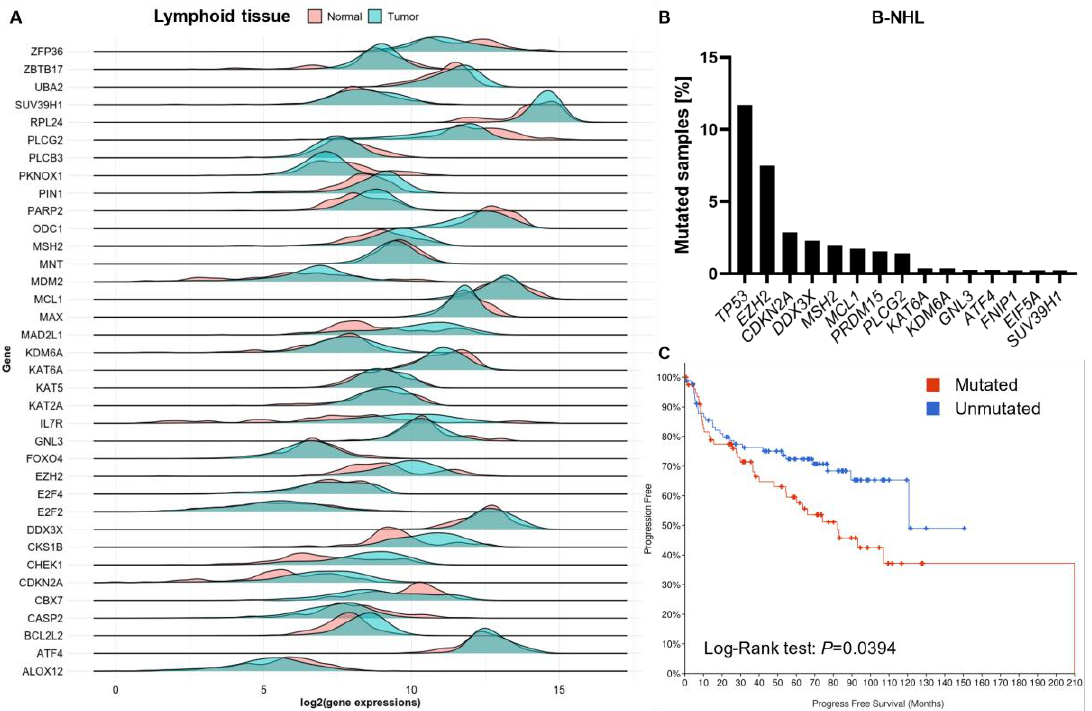
Figure 5. Critical genes for murine MYC-induced lymphoma play a role in human B-NHL. ( A ) Gene expression of the critical genes from Figure 2 is shown for normal and malignant human lymphoid tissue using the TNMplot tool [128]. ( B ) The mutation rate of the critical genes was assessed using cBioPortal [129,130]. A total of 41 out of 48 genes showed mutations in B-NHL. A total of 2117 samples from eight studies were included in the analysis. ( C ) Progression-free survival analysis of B-NHL patients with mutations (n = 81) or no mutations (n = 91) in the 48 critical genes derived from Eµ-Myc mice is shown. Overall survival was unaltered. Data and visualization are derived from cBioPortal [129,130].